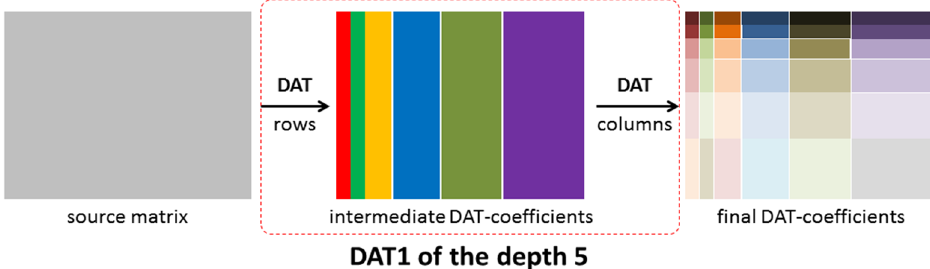
Figure 6. A structure of the matrix transform DAT1 of the depth 5.